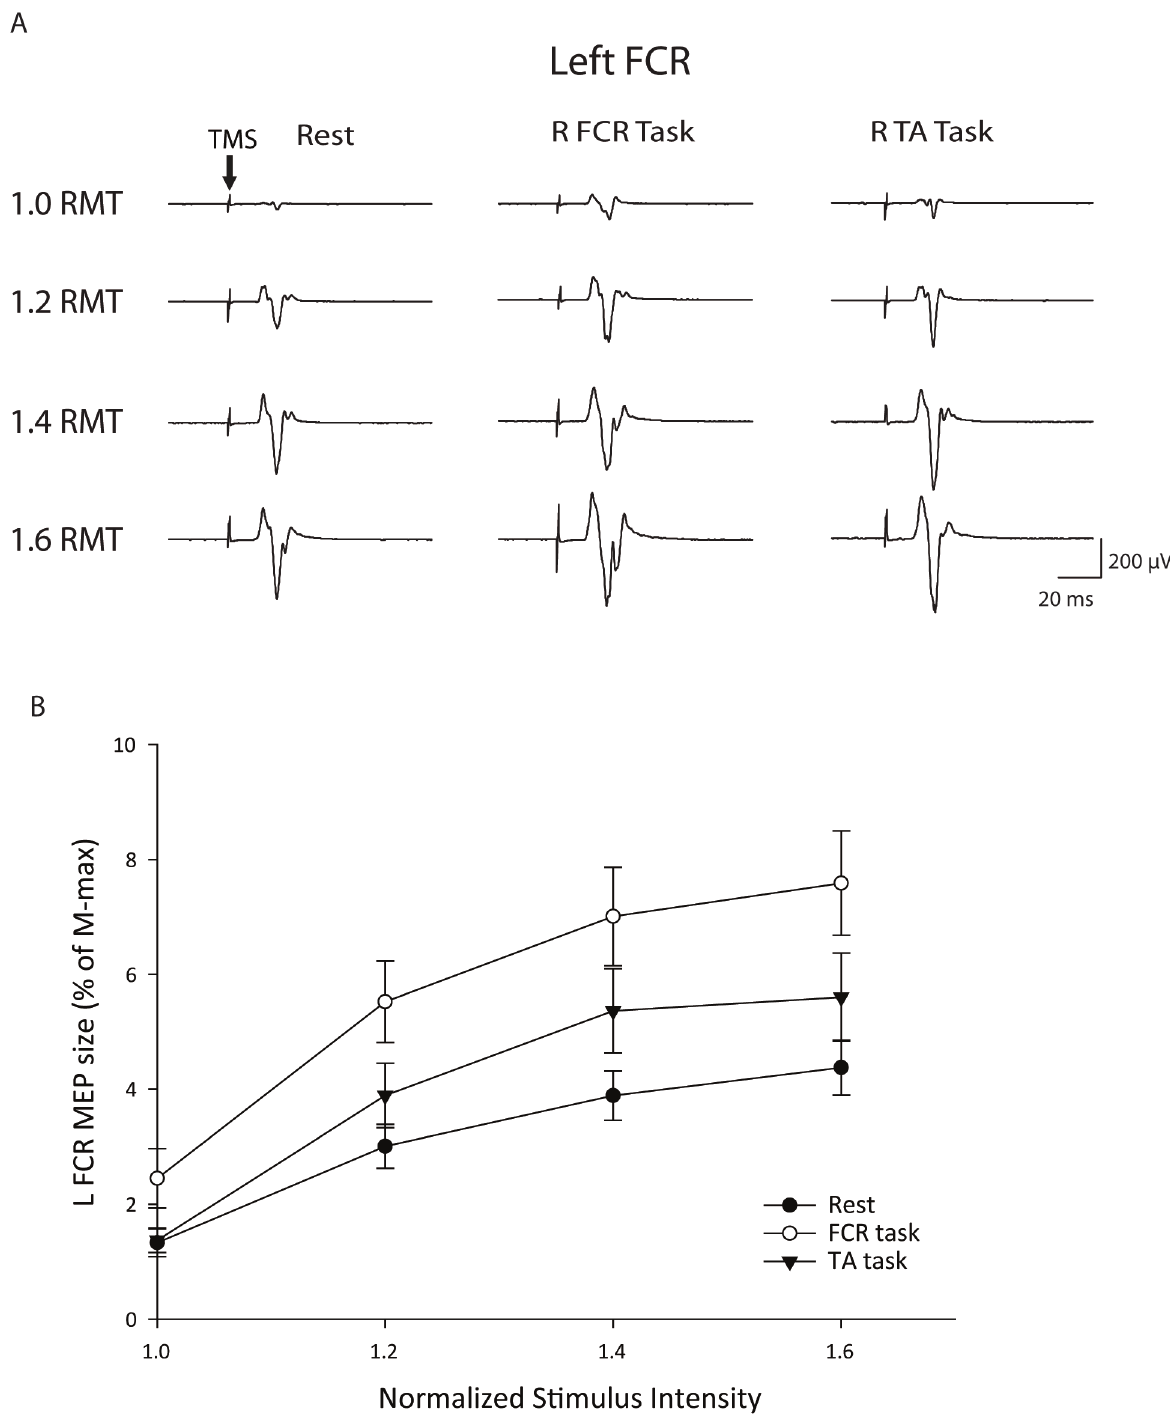
Figure 1. Recruitment curves in the left flexor carpi radialis (FCR). (A) The averaged MEPs recorded from a representative subject. (B) Group data (n=15) during performance of different motor tasks with right side limbs. The abscissa shows intensity of transcranial magnetic stimulus (TMS) expressed relative to the resting motor threshold (RMT) in each subject. The ordinate shows MEP amplitudes as a percentage of the left FCR M-max. Group data are presented as the mean 6 standard error. Arrows indicate delivery times of TMS. TA: tibialis anterior; R: right; L: